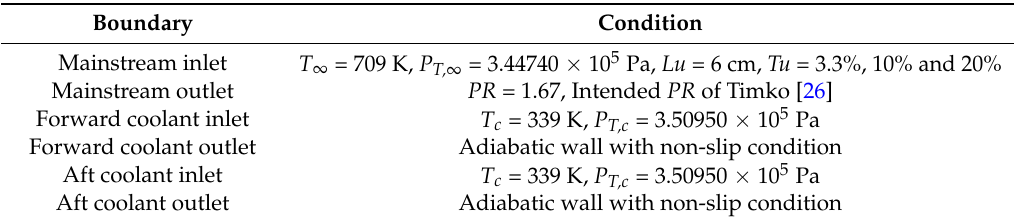
Table 3. Basic boundary conditions used in all simulations.